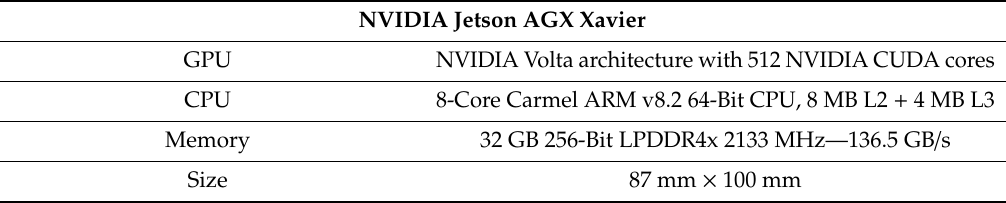
Table 5. Several key technical specifications of NVIDIA Jetson AGX Xavier module.